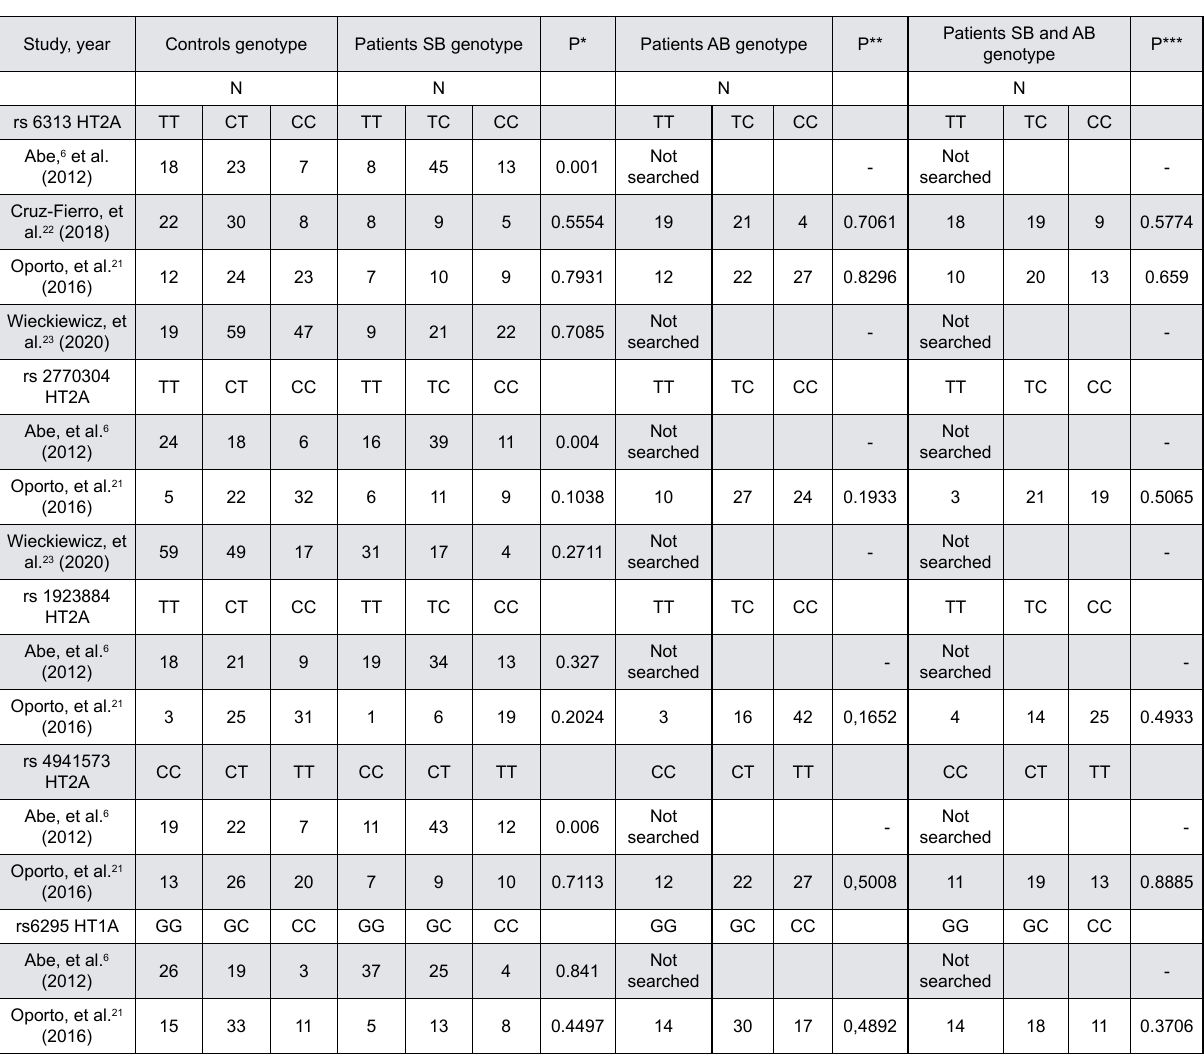
Figure 6- Genotypes of the SNPs of the 5- HT1A and 5-HT2A receptors genes in awake, sleep, or both